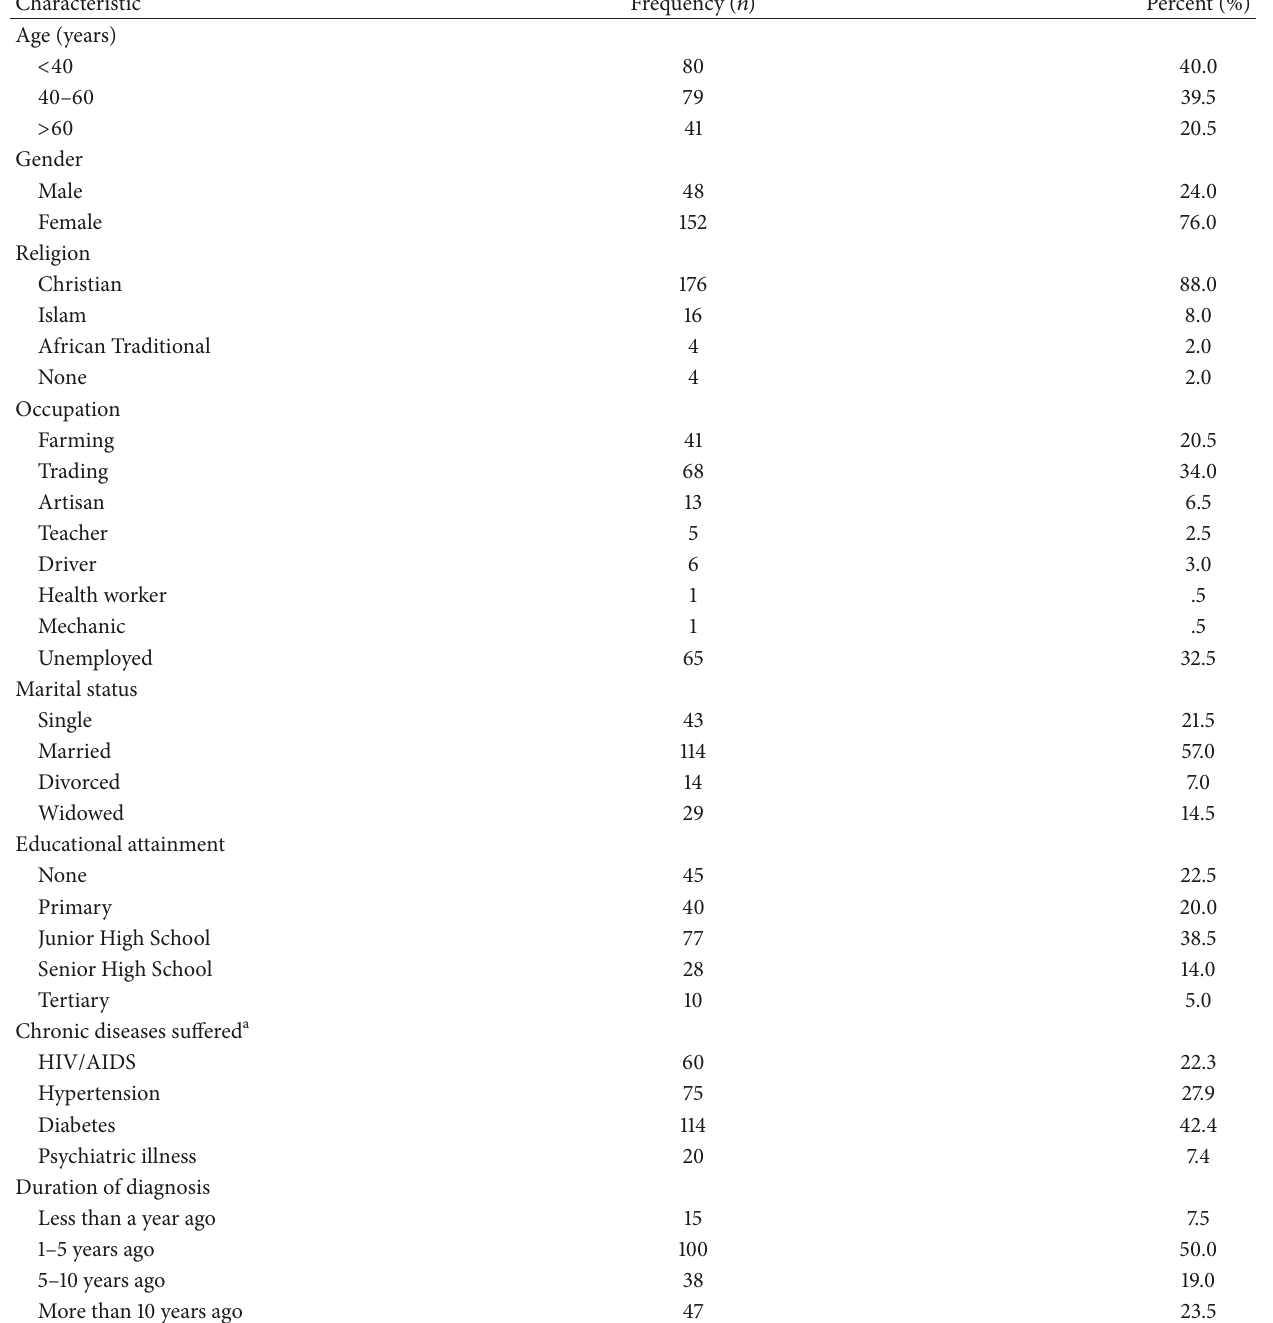
Table 1: Distribution of respondents by background characteristics ( 𝑁 = 200